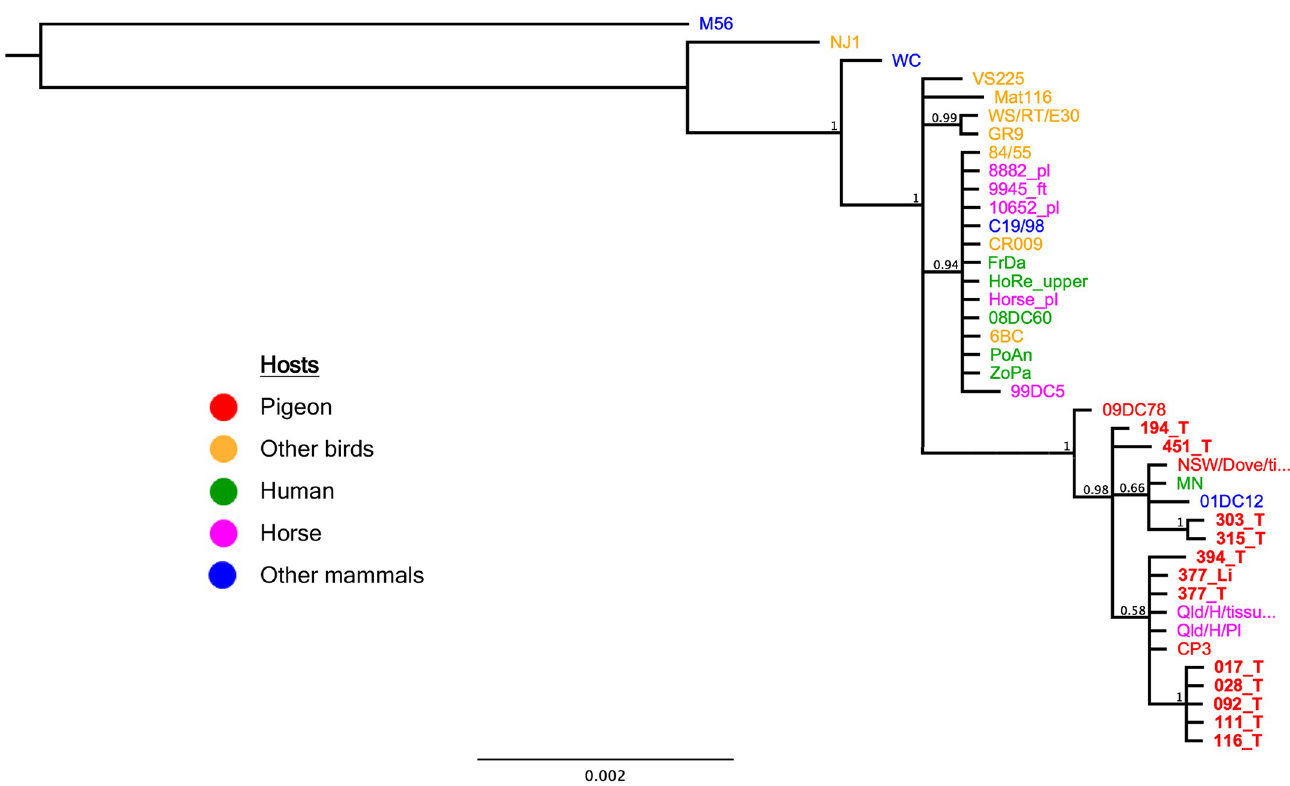
Fig 2. Bayesian phylogenetic tree of concatenated multilocus sequence typing (MLST) sequences from 40 Chlamydia psittaci strains from avian and mammalian hosts. The host is color-labeled as depicted in the legend. M56 taxa was used as an outgroup. Samples from this study are marked in bold letters. The posterior probability values are displayed on the tree